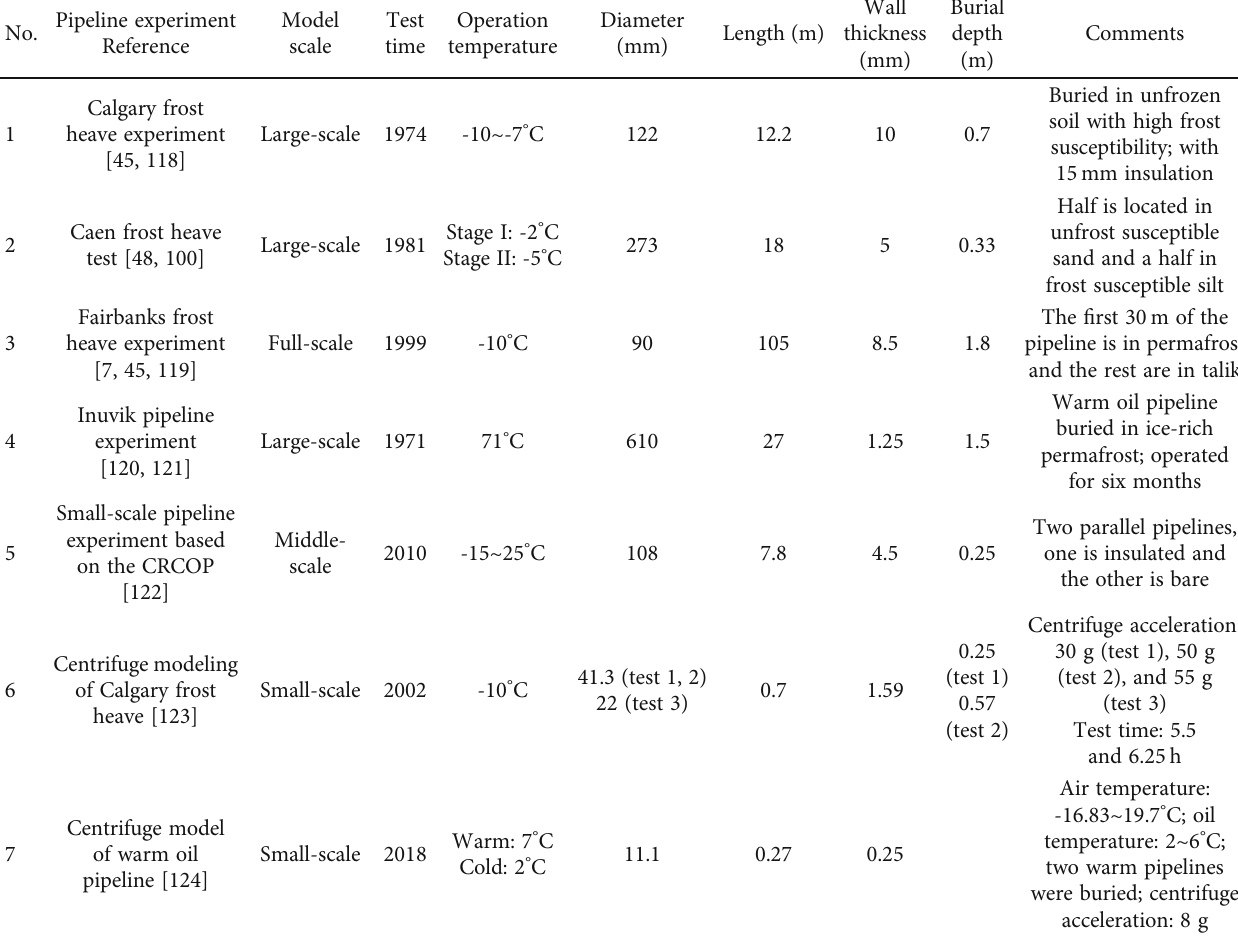
Table 2: Summary of the main experiments of the chilled and warm buried energy pipelines in permafrost regions. Pipeline experiment No.